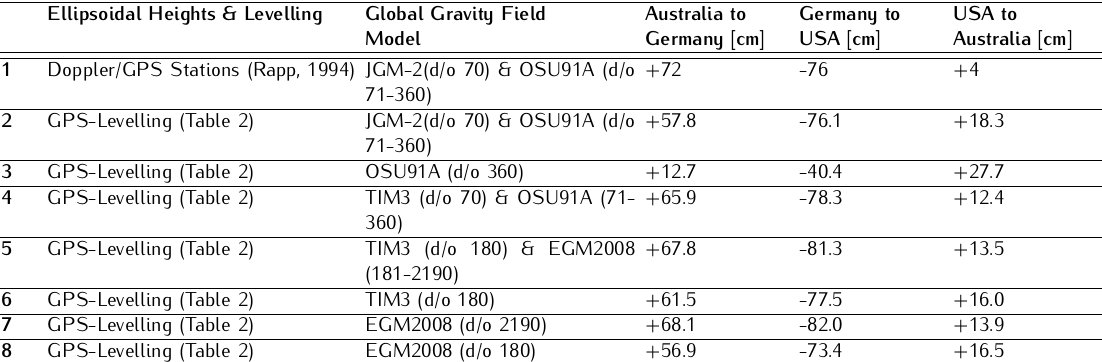
Table 4. Intercontinental height datum offsets between Australia, Germany and USA from ( Rapp 1994) and this study (d/o means that the global model has been used up to this degree). Ellipsoidal Heights &